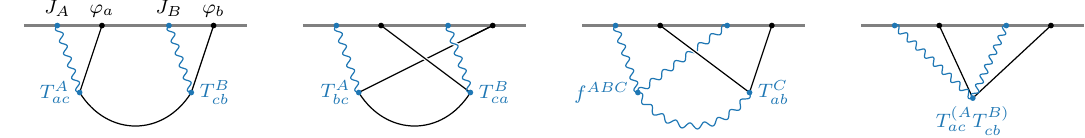
Figure 7: Diagrammatic representation of the contributions to the non-Abelian Compton